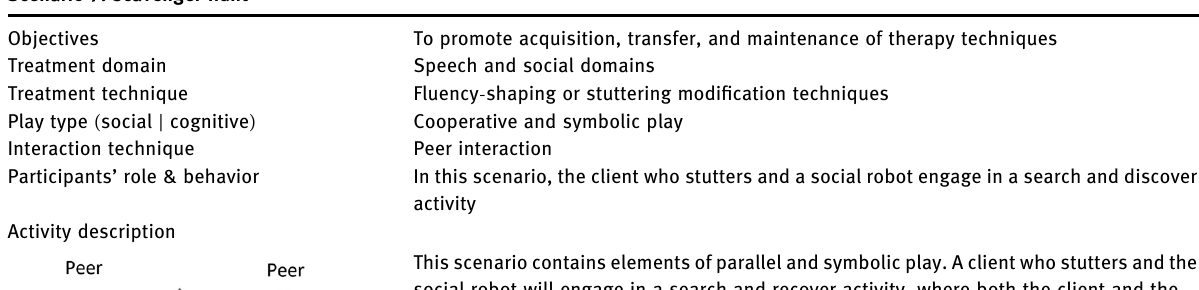
Table 7: Description of scenario 7 Scenario 7: scavenger